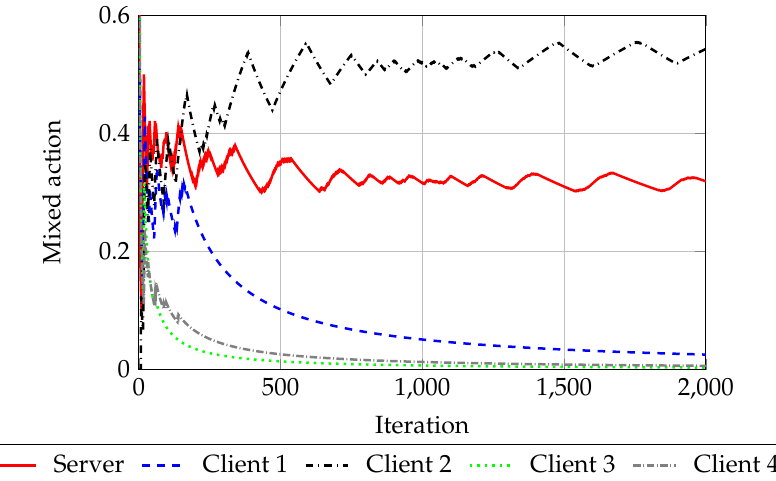
Figure 5. Example the evolution of the mixed action for each player, using RM algorithm, where Cl stands for client. In each simulation, all clients tend to play ns , except for one. This one randomly arises at each simulation using RM algorithm. This means that the game tends to the two player situation.